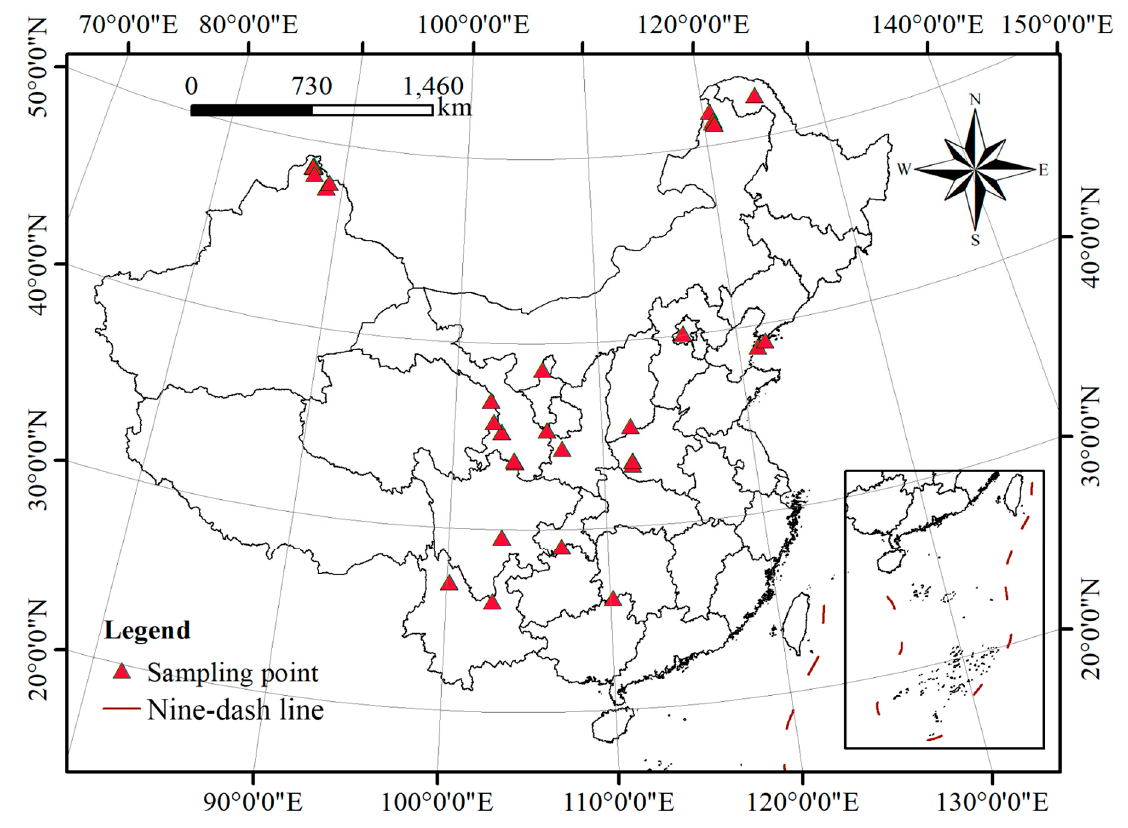
Figure 6. Ribes L. sampling sites in China.